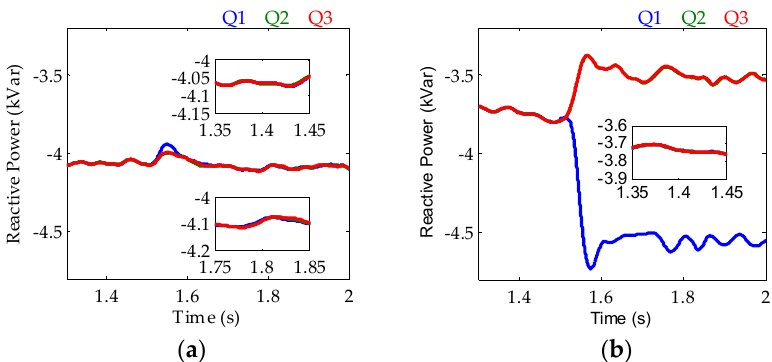
Figure 11. Simulation waveforms of dc-link voltage and active power of CHBR modules under load variation by use of ( a ) the proposed control strategy and ( b ) the conventional control strategy.